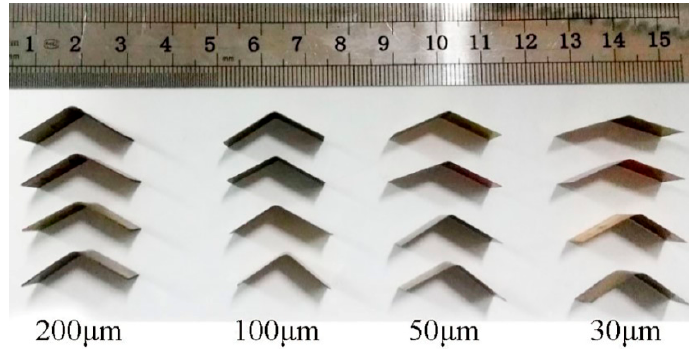
Figure 3. Morphology of foil specimens with different thickness after bending.